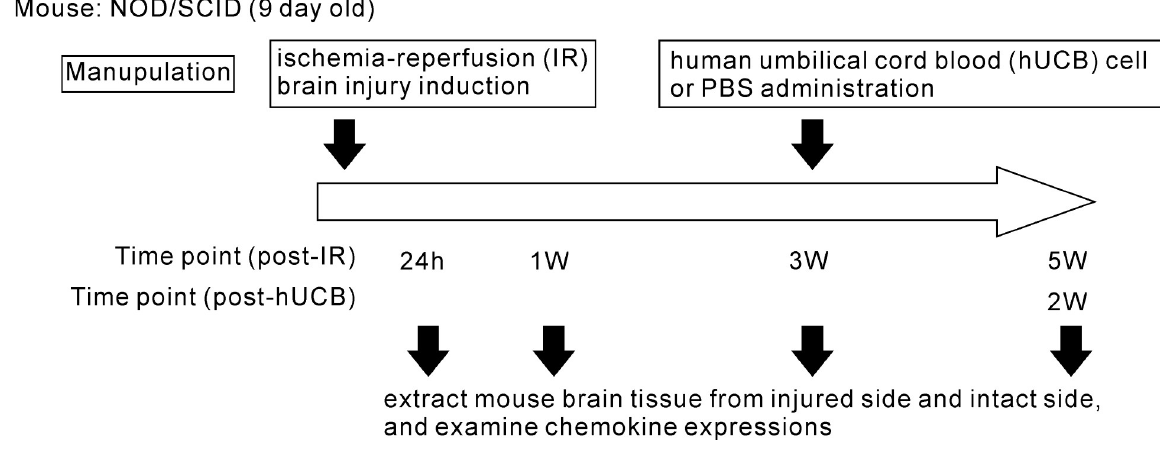
Fig 1. Schematic illustration of experimental